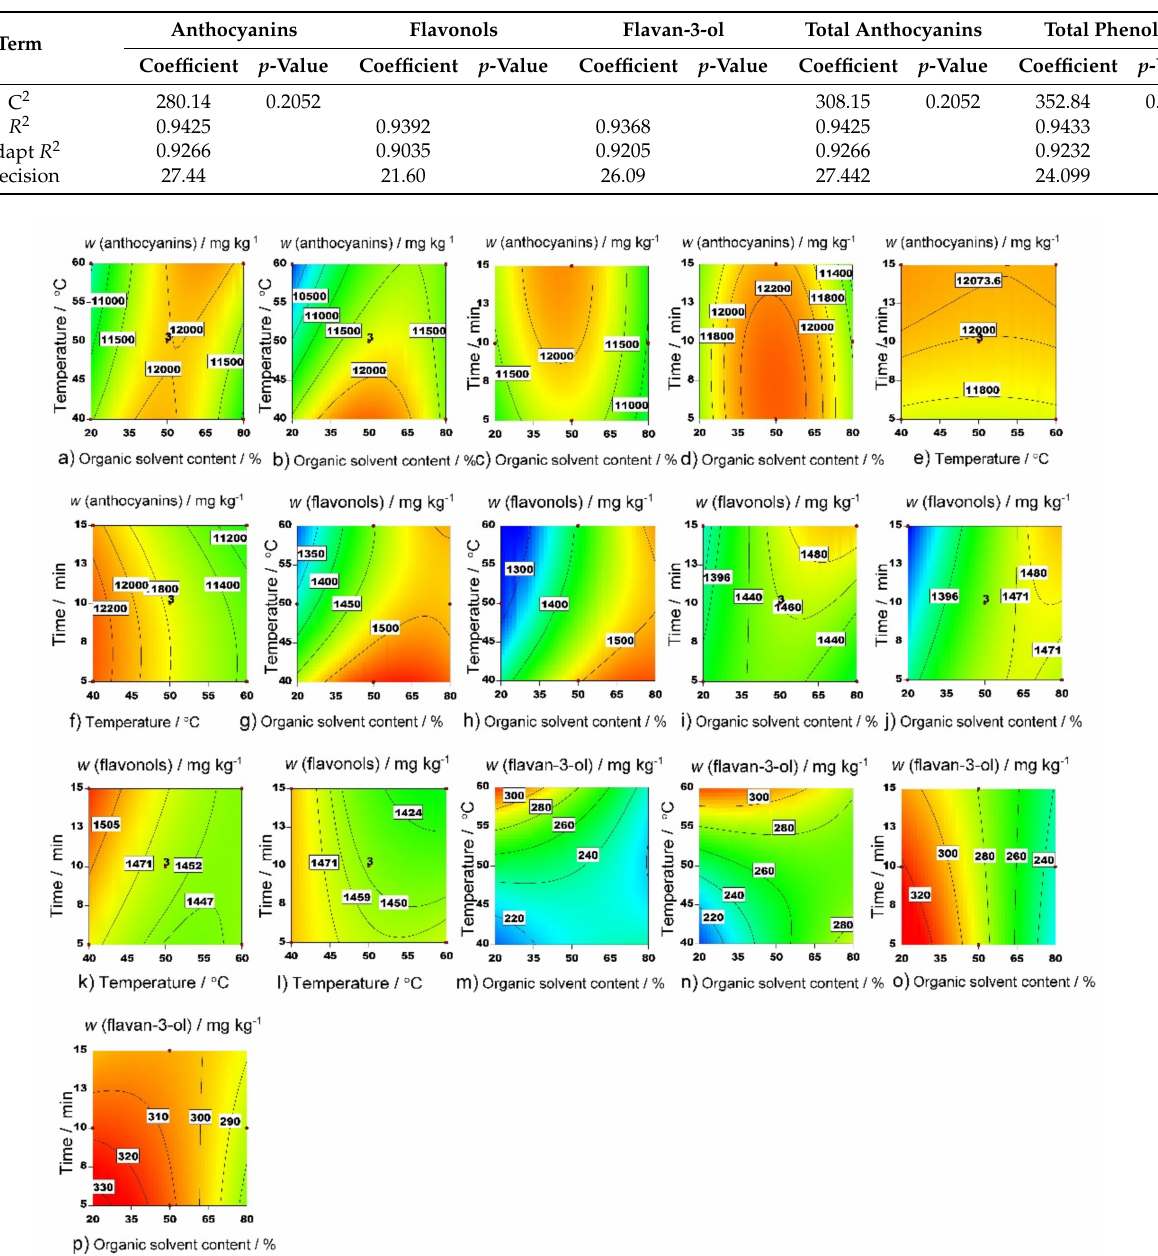
Figure 4. Contour plots of the most significant interaction effects on the contents of ( a ) anthocyanin with ACN as the organic phase and ( b ) anthocyanin with EtOH as the organic phase, with an extraction time of 10 min; ( c ) anthocyanin with ACN as the organic phase and ( d ) anthocyanin with EtOH as the organic phase at 50 ◦ C; ( e ) anthocyanin with ACN as the organic phase and ( f ) anthocyanin with EtOH as the organic phase in a content of 50%; ( g ) flavonol with ACN as the organic phase and ( h ) flavonol with EtOH as the organic phase, with an extraction time of 15 min; ( i ) flavonol with ACN as the organic phase and ( j ) flavonol with EtOH as the organic phase at 50 ◦ C; ( k ) flavonol with ACN as the organic phase and ( l ) flavonol with EtOH as the organic phase in a content of 50%; ( m ) flavan-3-ol with ACN as the organic phase and ( n ) flavan-3-ol with EtOH as the organic phase, with an extraction time of 10 min; and ( o ) flavan-3-ol with ACN as the organic phase and ( p ) flavan-3-ol with EtOH as the organic phase at 60 ◦